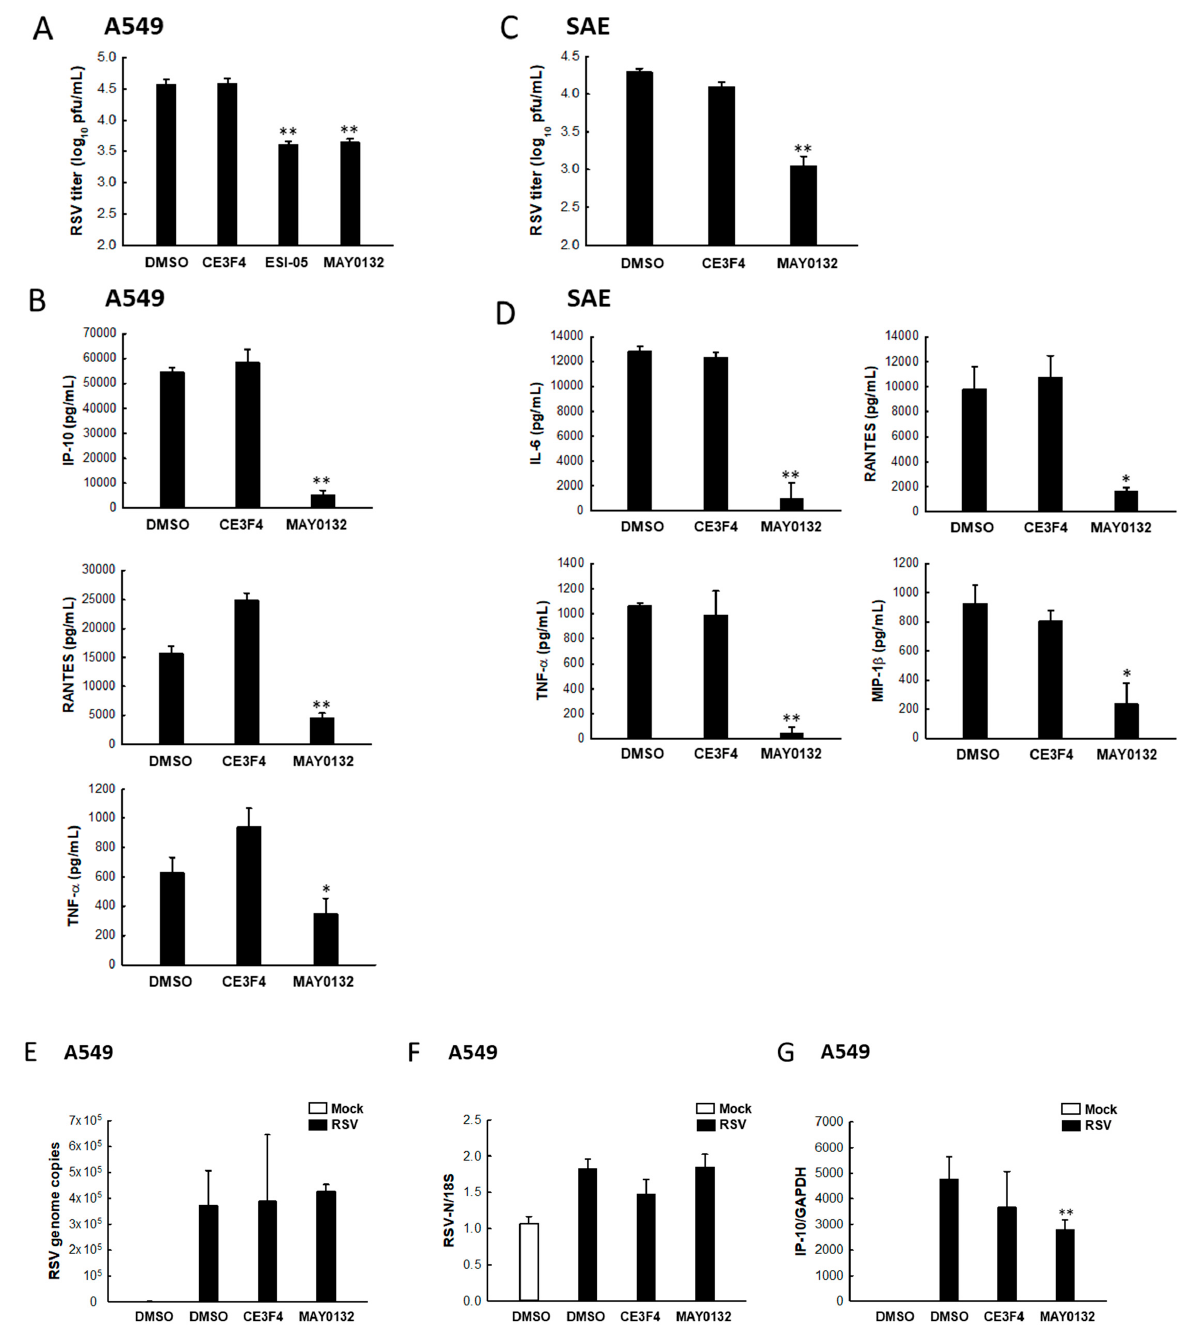
Figure 5. The impact of EPAC2 on RSV infection. ( A , B ) A549 cells in triplicate were infected with RSV at an MOI of